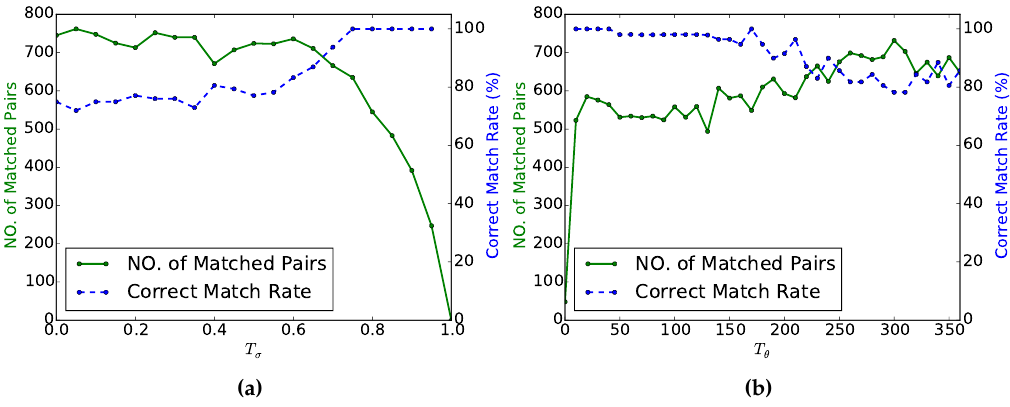
Figure 3. The numbers of matched pairs and correct match rates for different values of T σ and T θ . ( a ) The results with respect to different values of T σ ; ( b ) the results with respect to different values of T θ